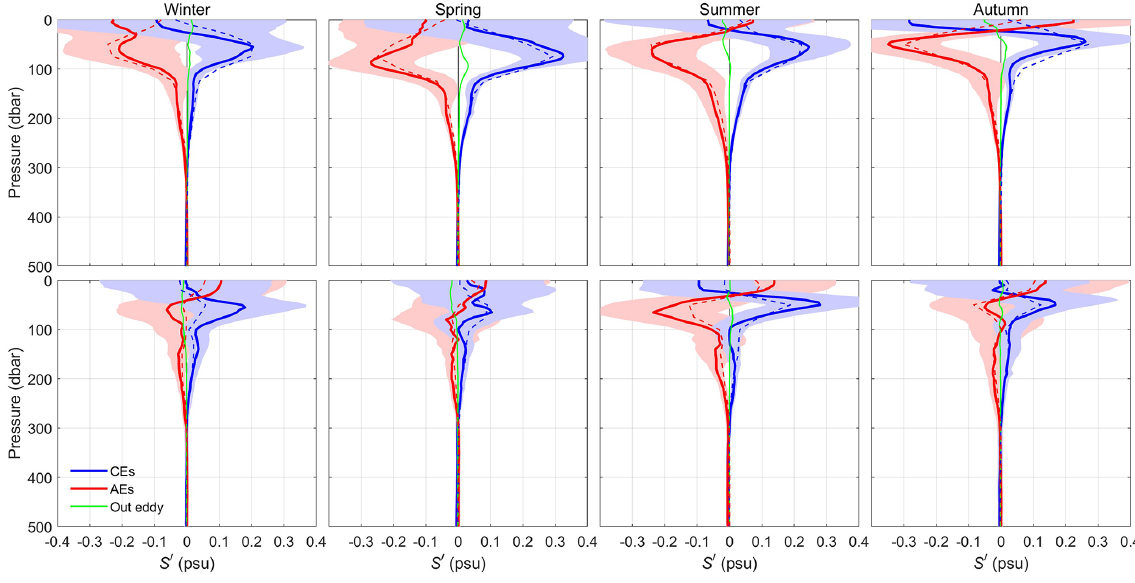
Figure 7. Same as Fig. 6 but for salinity anomaly S (cid:48)